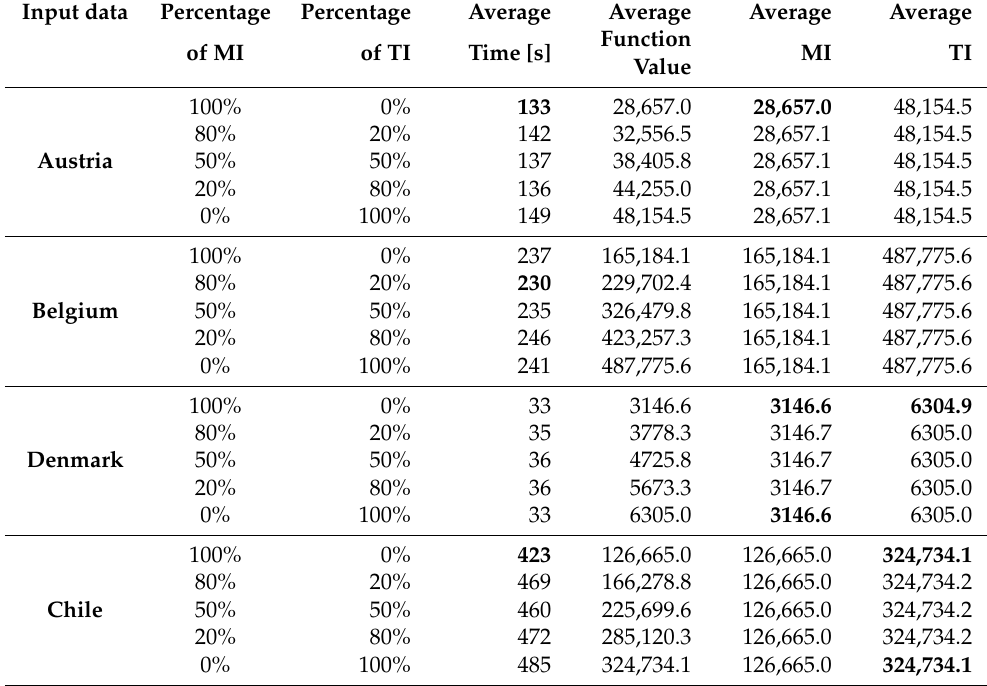
Table 6. Average time, maximum infected as MI, total infected as TI, and average function value per problem for different weighing in the evaluation function. The best time per file is highlighted in bold, and the best objective function value is shown in